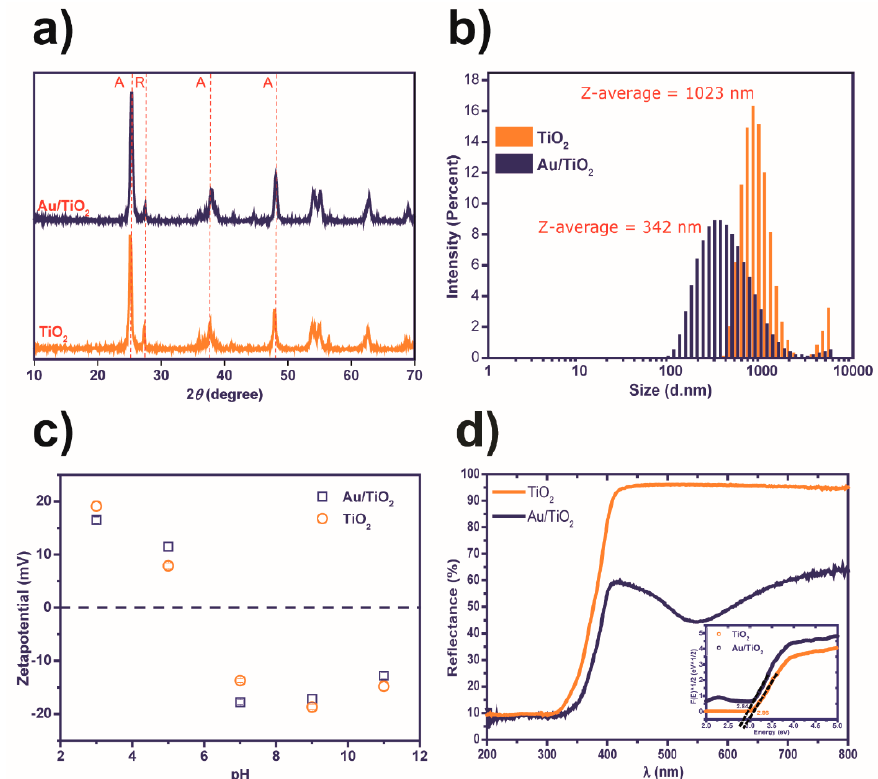
Figure 4. X-ray di ff raction reflexes of pristine TiO 2 and Au / TiO 2 nanocomposite and identification of the representative peaks for anatase (A) and rutile (R) phases ( a ); dynamic light scattering, intensity size distribution of the pristine TiO 2 and the Au / TiO 2 nanocomposite and respective Z-average hydrodynamic size ( b ); zeta potential measurements, performed at di ff erent pHs (3, 5, 7, 9, and 11) for pristine TiO 2 nanoparticles and Au / TiO 2 nanocomposite ( c ); UV–vis reflectance spectra of pristine TiO 2 and Au / TiO 2 and (inset) the estimation of the bandgap for both samples at (F(R))1 / 2 = 0 ( d ). The Au / TiO 2 nanocomposite synthesized at 60 ◦ C and with an Au loading of 0.05 wt. % was used.